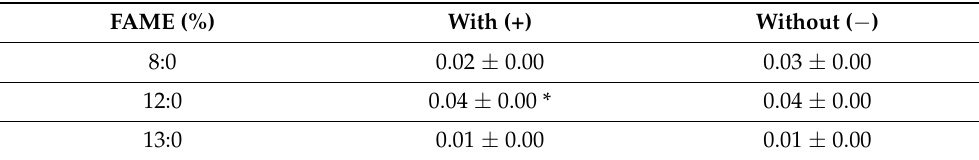
Table 2. Fatty acid composition of 26-day dry-aged beef with (+) and without ( − ) direct fungal